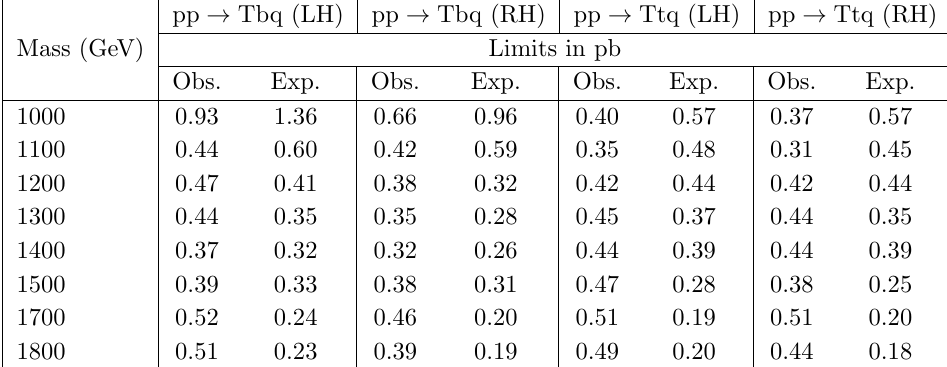
Table 4 . The observed and expected 95% con(cid:12)dence level upper limits on the product of the signal cross sections and the branching fraction B (T ! tH), for various masses of the T